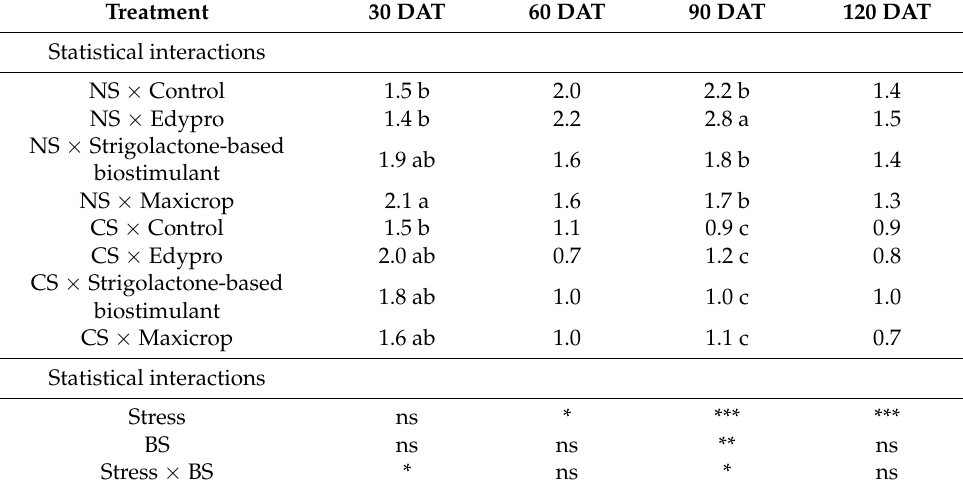
Figure 4. Effects of combined water and nutrient stress and biostimulant application (Control: No biostimulant applied, Edypro: application of COUPÉ REGENERACIÓN and PROCUAJE RADIC- ULAR, strigolactone-based biostimulant, and Maxicrop) on tomato aboveground biomass (g) ( i ) 70 days after transplanting, and ( ii ) at the end of the cultivation period. Means ( n = 4) followed by different letters indicate significant differences according to Duncan’s multiple range test ( p < 0.05). On the other hand, at 70 DAT, the leaf area of plants cultivated under optimal water and nutrient supply was reduced when biostimulants were applied to plants (Figure 5i). In contrast, under combined stress conditions, the strigolactone-based biostimulant in- creased leaf area compared to untreated plants and plants treated with Edypro biostimu- lants. In fact, the increase in leaf area in plants cultivated under combined stressed condi- tions and treated with strigolactone-based biostimulant was comparable with the control plants cultivated under optimal water and nutrient supply. At the end of the cultivation, however, biostimulants did not have any significant impact on the tomato leaf area (Fig- ure 5ii).